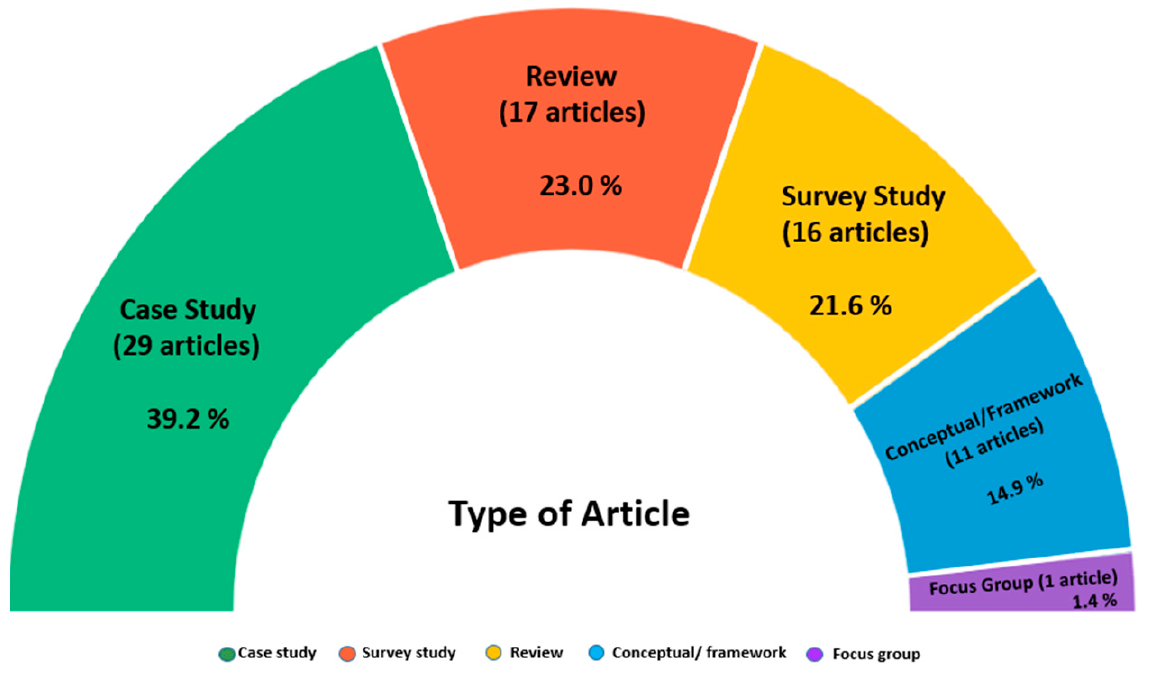
Figure 6. Primary industries identified by the reviewed articles.